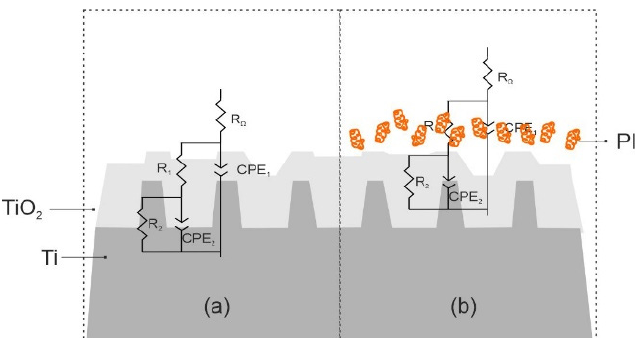
Figure 6. The structure of ( a ) uncoated Ti/TiO 2 surface and ( b ) polyion (PI) coated Ti/TiO 2 surface: two time constants are attributed to the outer and inner part of the surface polyelectrolyte coating formed over spontaneous TiO 2 oxide film.